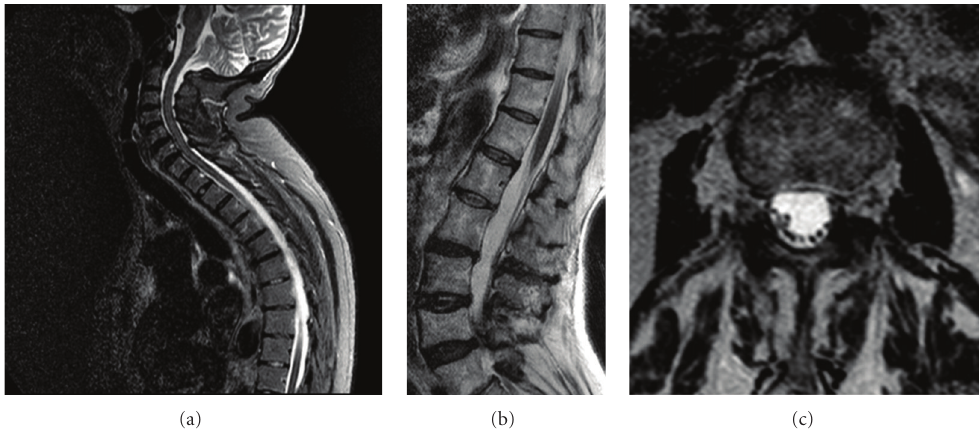
Figure 4: Hypointensities around the brainstem and all along the spinal cord are depicted in both sagittal MRI STIR-adquired images ((a) and (b)). The thecal cul-de-sac is occupied by iron-containing debris (b). There are also signs of arachnoiditis such as lumbar nerve root clumping ((b) and